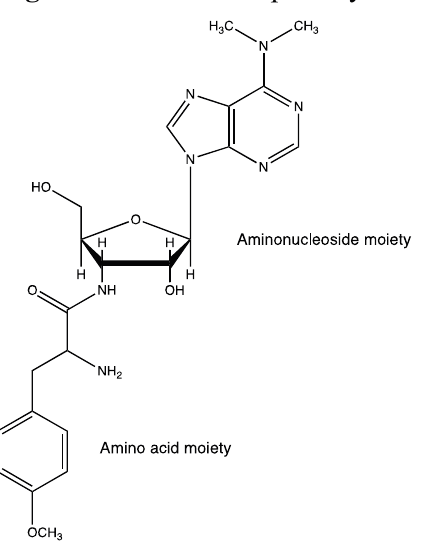
Figure 6. Structure of